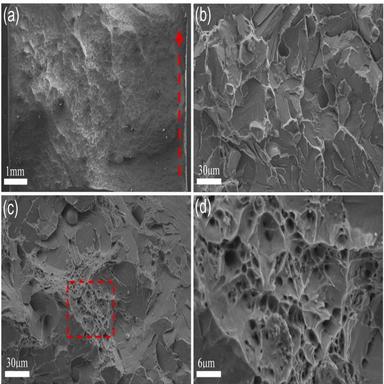
SEM images of the fracture surface of 1440–600 sample. (a) Low-magnification, (b–d) High-magnification. (d) Magnified image of the red rectangular region in (c). (For interpretation of the references to colour in this figure legend, the reader is referred to the Web version of this article.)